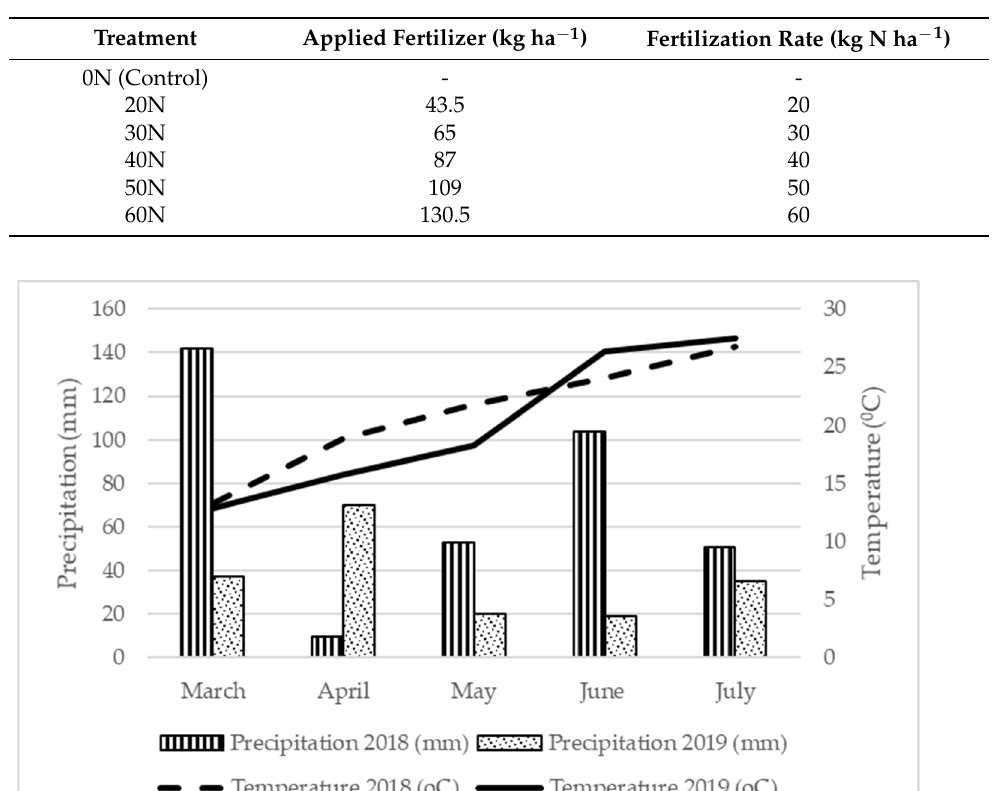
Table 5. Treatments and amount of applied N fertilization.